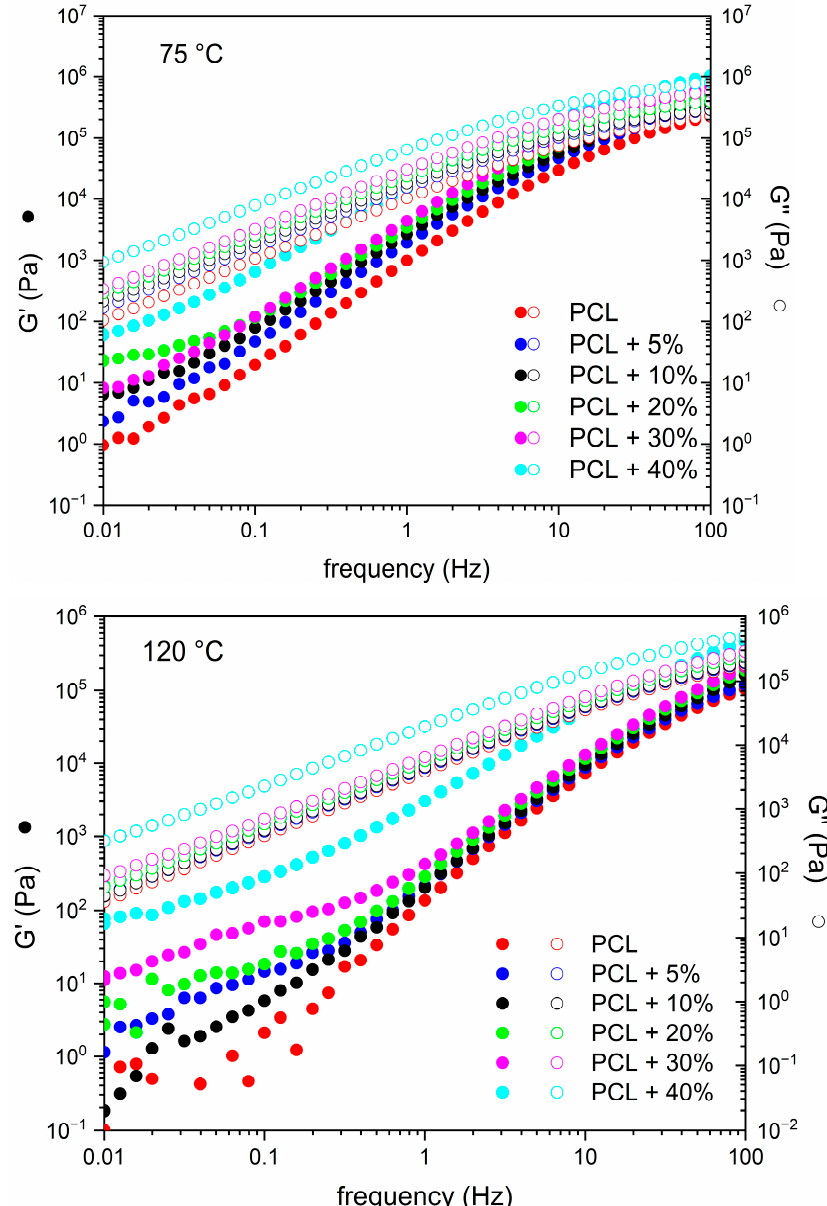
Figure 2. The frequency sweep of PCL and its composites with hollow glass beads at 75°C and 120°C.